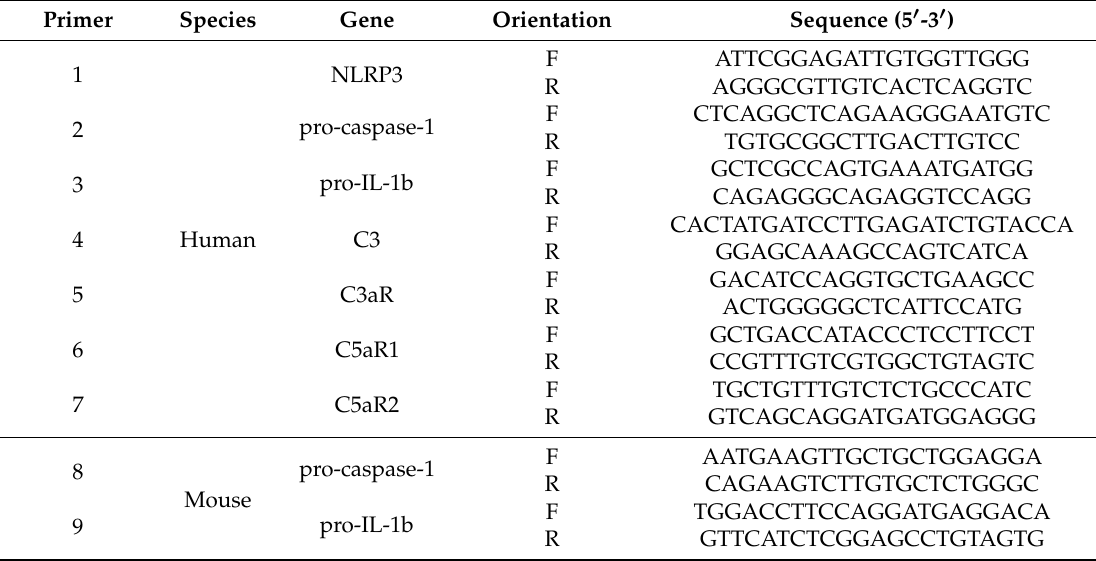
Table 1. Primers used to amplify inflammasome and complement